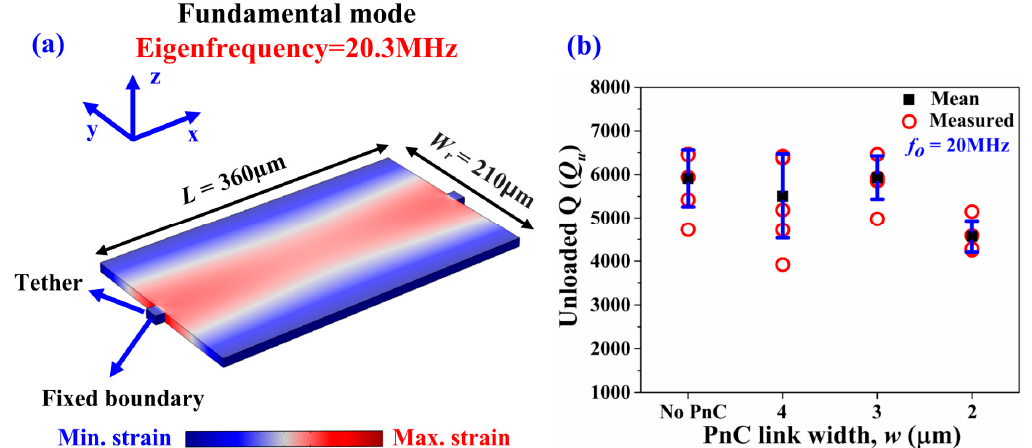
Figure 10. ( a ) FE simulation of the fundamental Lamb mode (occurring around 20.3 MHz) where the contours denote the associated y-direction strain component. ( b ) Fully covered resonators with seven IDT fingers—Extracted values of unloaded Q ( Q u ) of the control design with no PnCs compared to the other three designs with PnCs in the anchors with different inter-cell link widths transduced at the fundamental Lamb mode (20.3 MHz), which lies outside the ABG. The black squares denote the mean value, while the error bars denote the standard deviation over four samples.